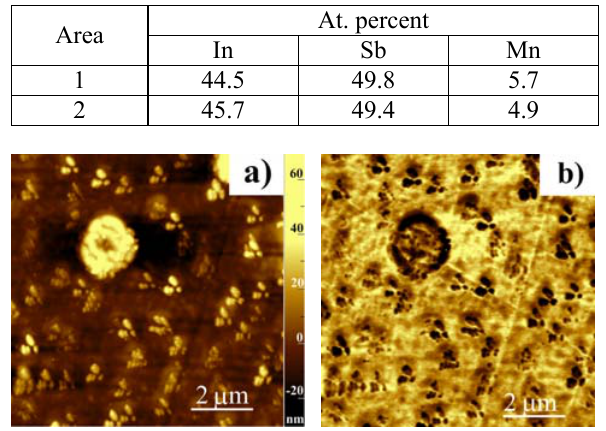
Fig. 2. Images of a site of the surface for the